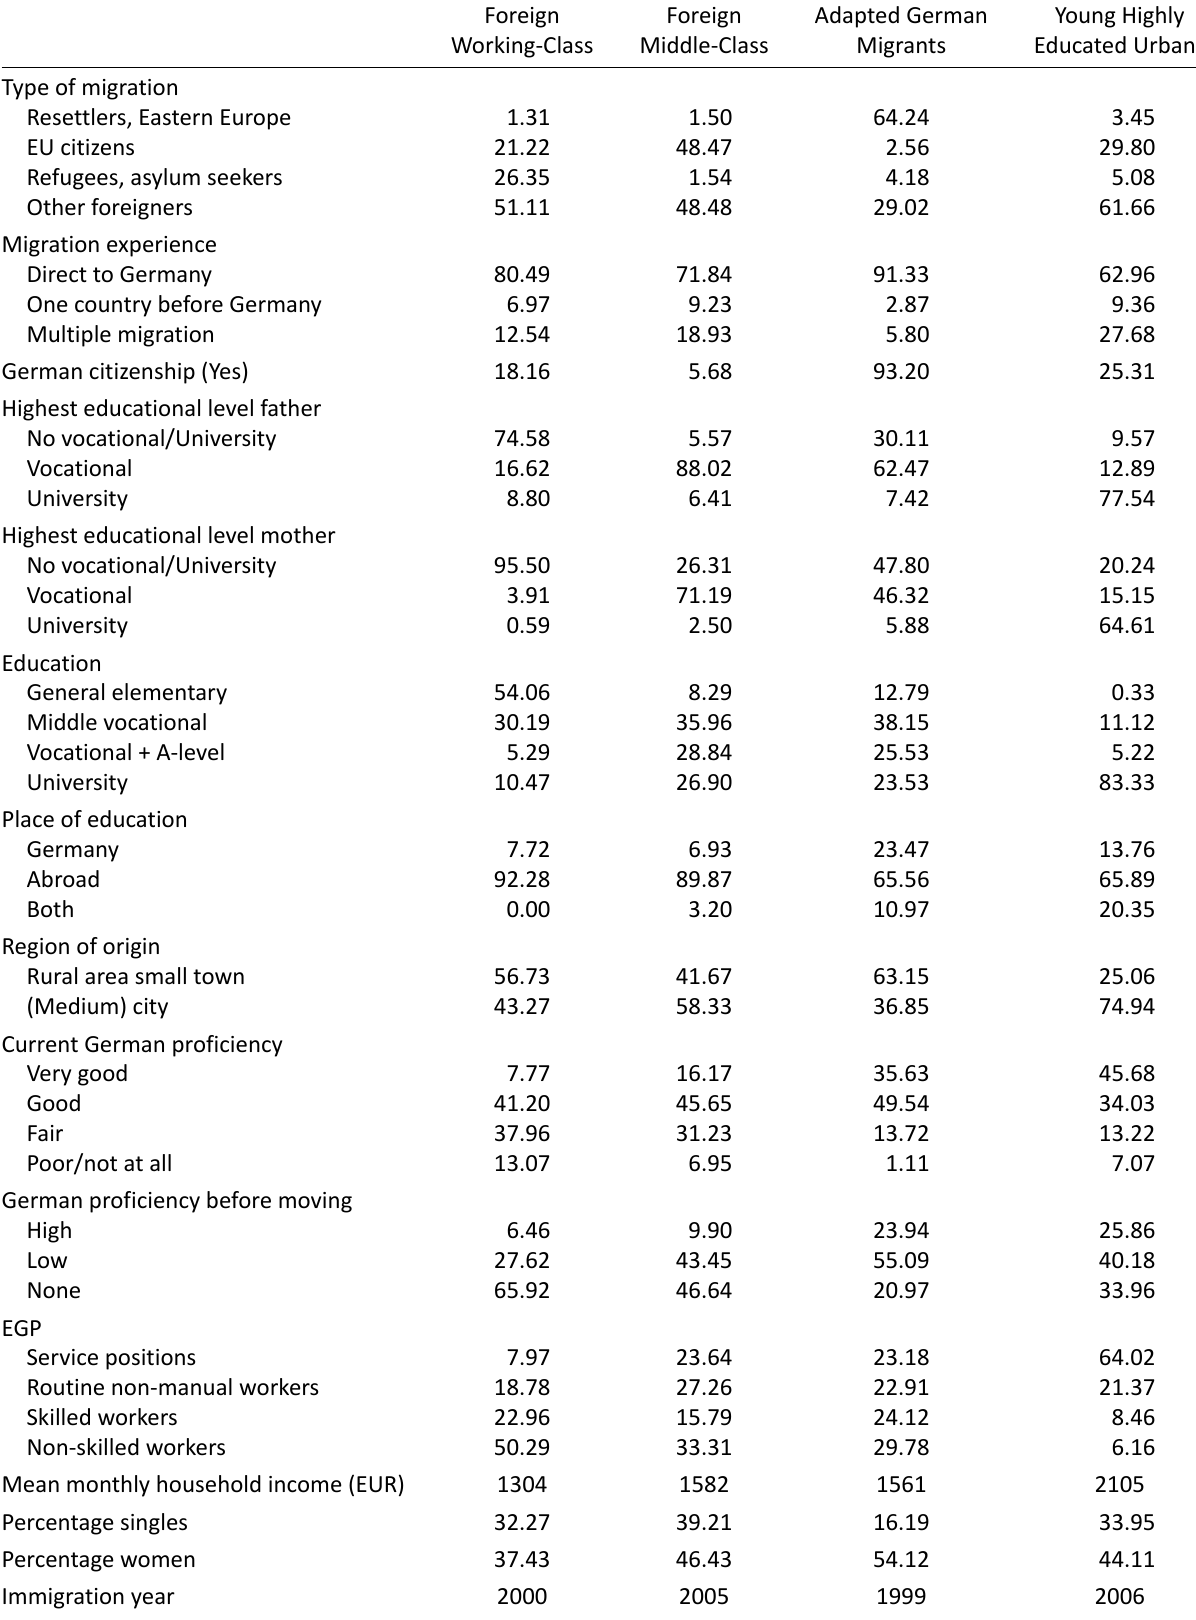
Table 3. Description of the clusters (column percentages). Foreign Foreign Adapted German Young Highly Working-Class Middle-Class Migrants Educated